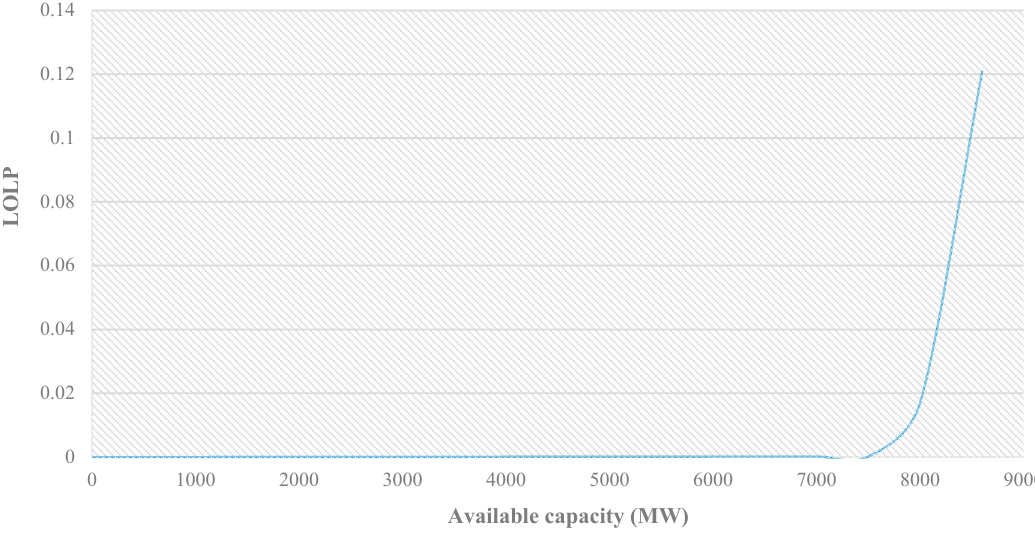
Figure 16. Loss of load probability (LOLP) curve as a function of the Greek residual load from October 2012 to September 2013.